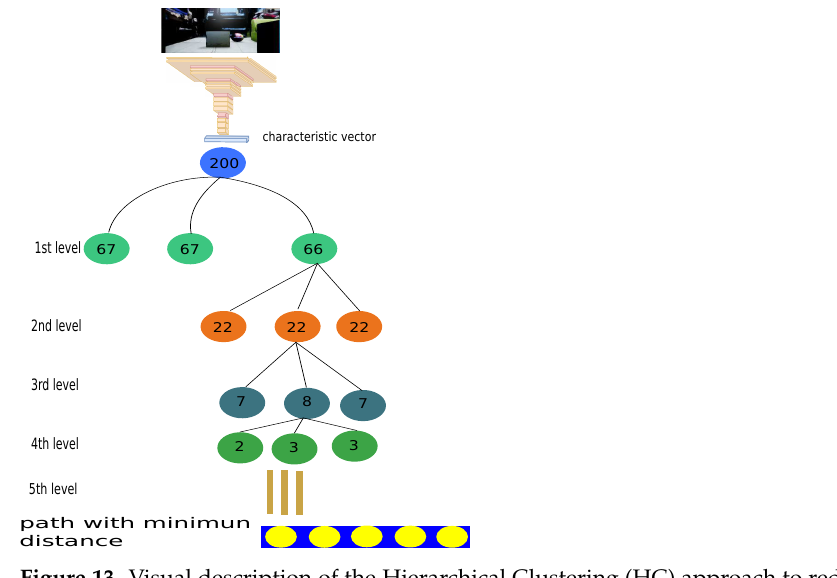
Figure 13. Visual description of the Hierarchical Clustering (HC) approach to reduce the number of